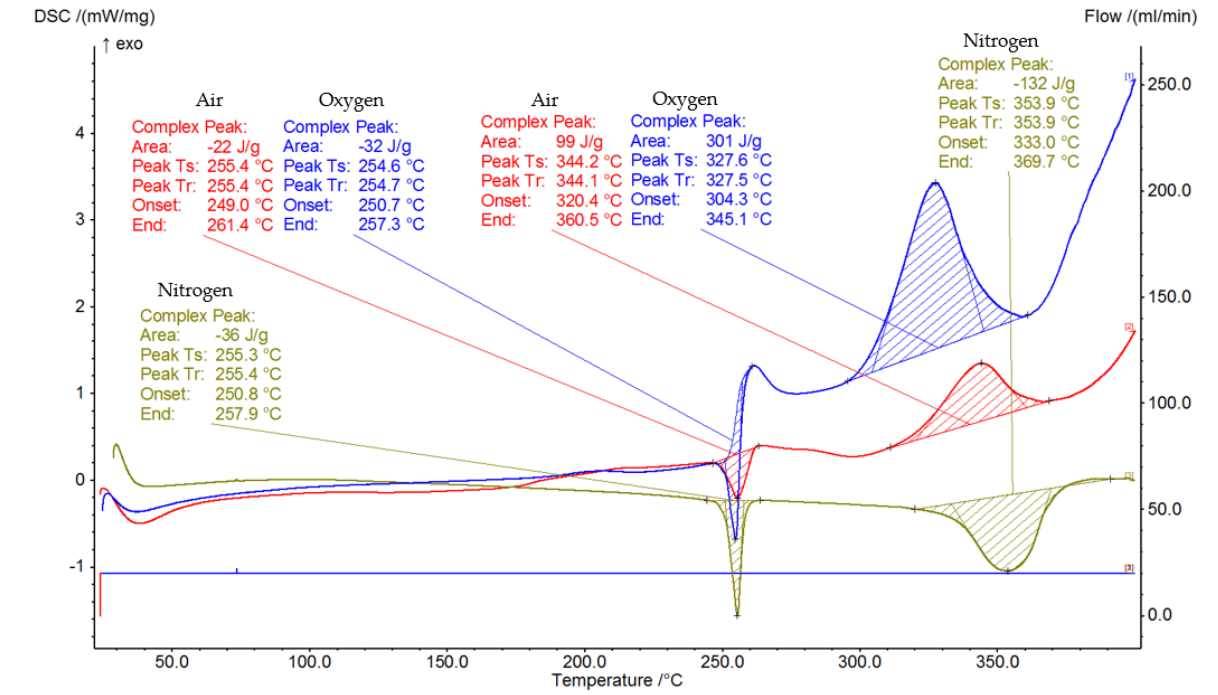
Figure 4. Differential scanning calorimetry curves of cotton fabric in an oxygen-free, 21% oxygen (air), and 100% oxygen (pure oxygen) atmosphere.